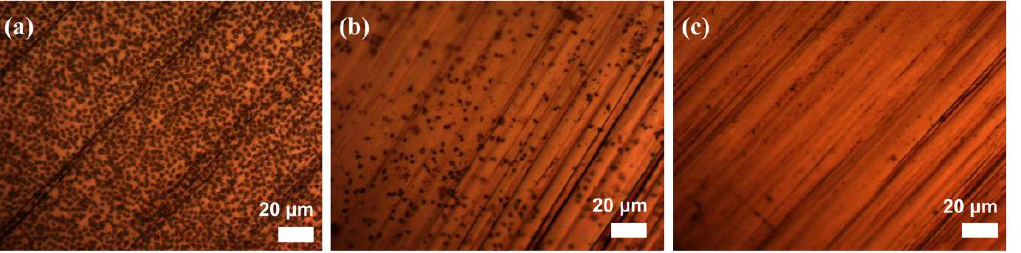
Figure 6. Platelet adhesion images acquired under different amplification times observed under op- tical microscopy for ( a ) ordinary iron, ( b ) structured iron and ( c ) superhydrophobic iron.